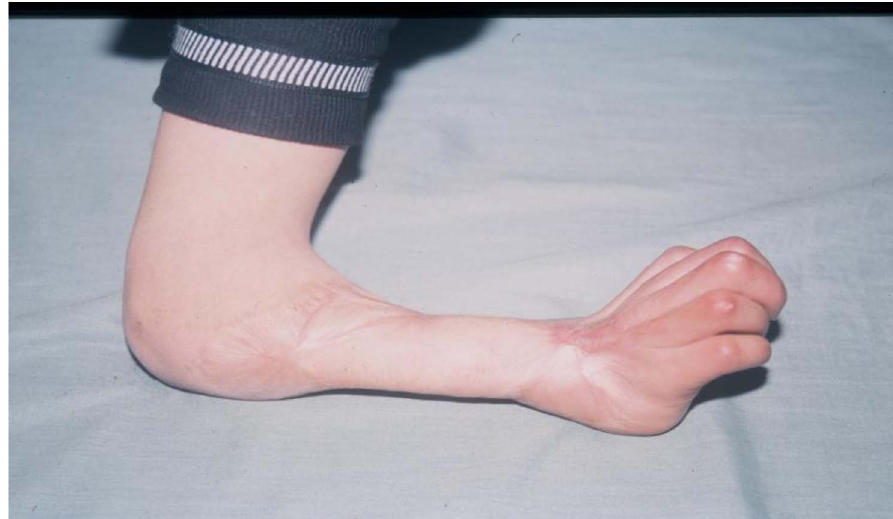
Figure 6. Severe case characterized by necrosis of fl exor and extensor